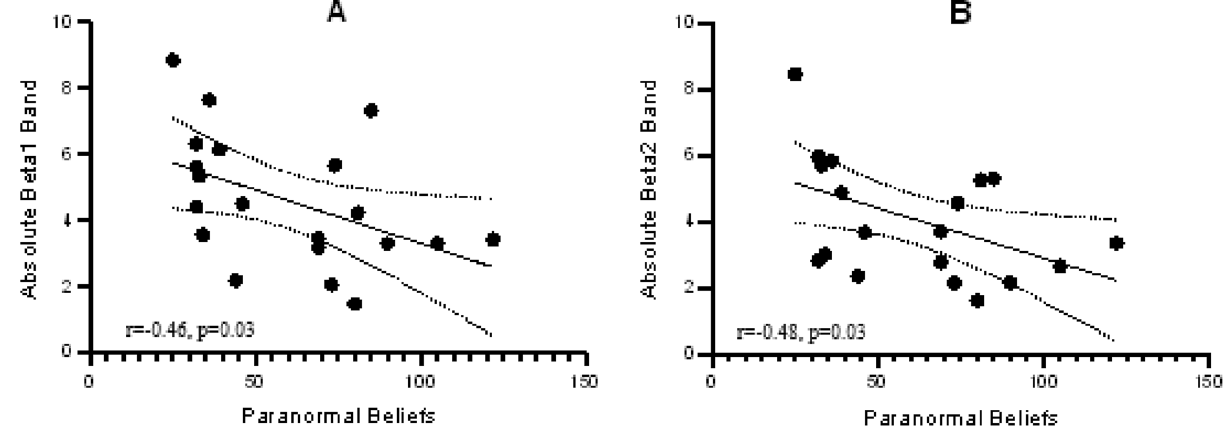
Figure 5. The figure of correlation between EEG power bands and paranormal beliefs score. The X-axis represents the scores of paranormal beliefs and the Y-axis the absolute power in ( A ) beta1, and ( B ) beta2 bands. Line dots are presented %95 confidence band of the best fit-line.